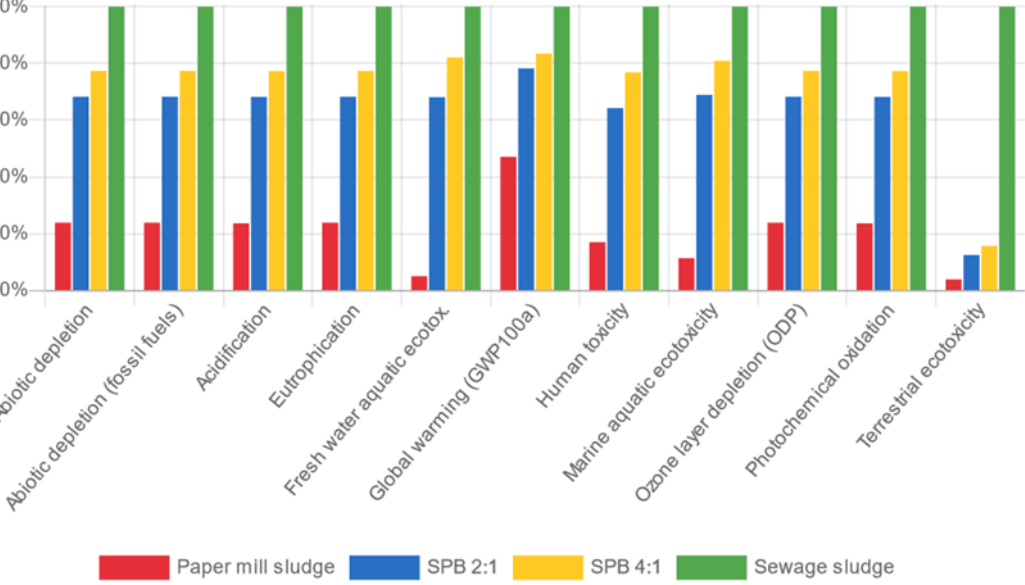
Figure 4. Relative indicator results of the pelletized fuels for the production of 1 MJ heat (drawn in the openLCA software, Berlin, Germany, v1.10.3).